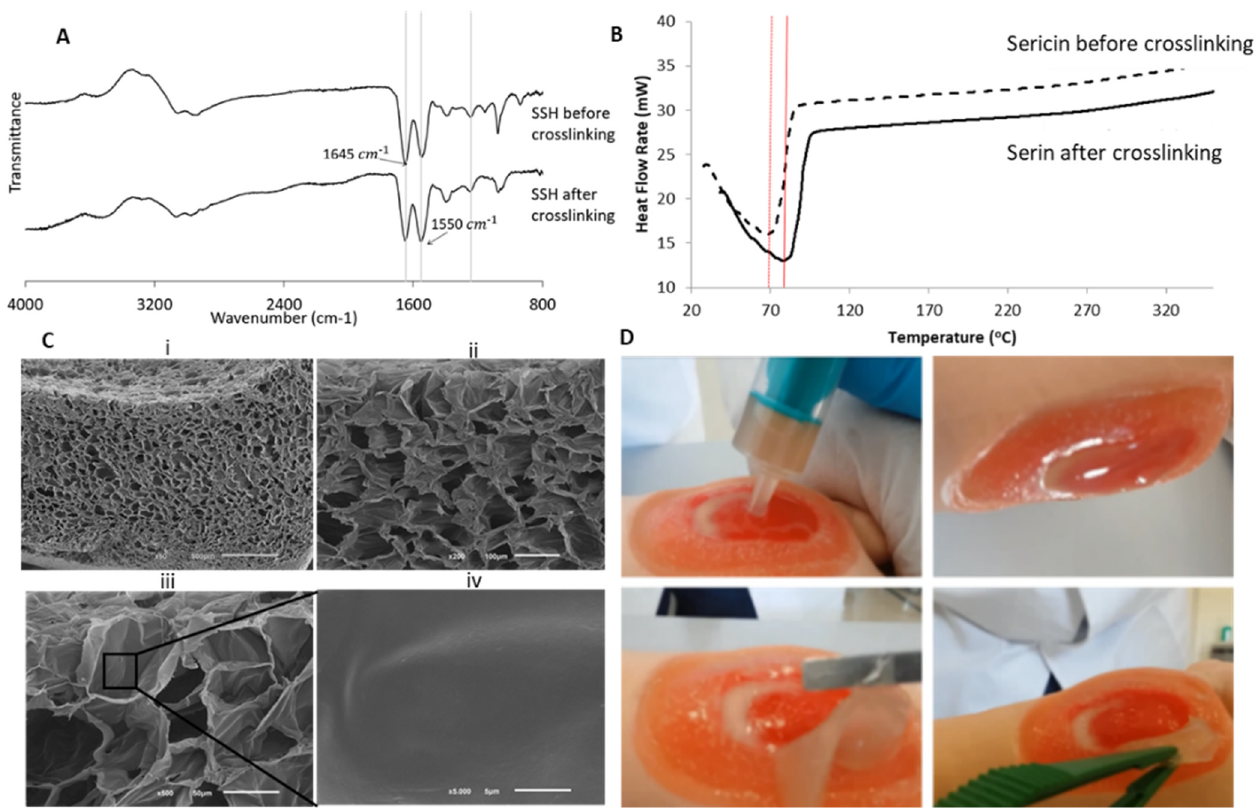
Figure 2. ( A ) FTIR analysis of SSH before and after crosslinking; ( B ) Thermogram of SSH before and after crosslinking; ( C ) SEM micrographs of lyophilized sericin-based hydrogels at different magnification ( i ) 50×, ( ii ) 200×; ( iii ) 500×, and ( iv ) 5000×; ( D ) SSH applied in situ on a wound × , ( ii ) 200 × ; ( iii ) 500 × , and ( iv ) 5000 × ; ( D ) SSH applied in situ on a wound simulator and macroscopic analysis. magnification ( i ) 50 simulator and macroscopic